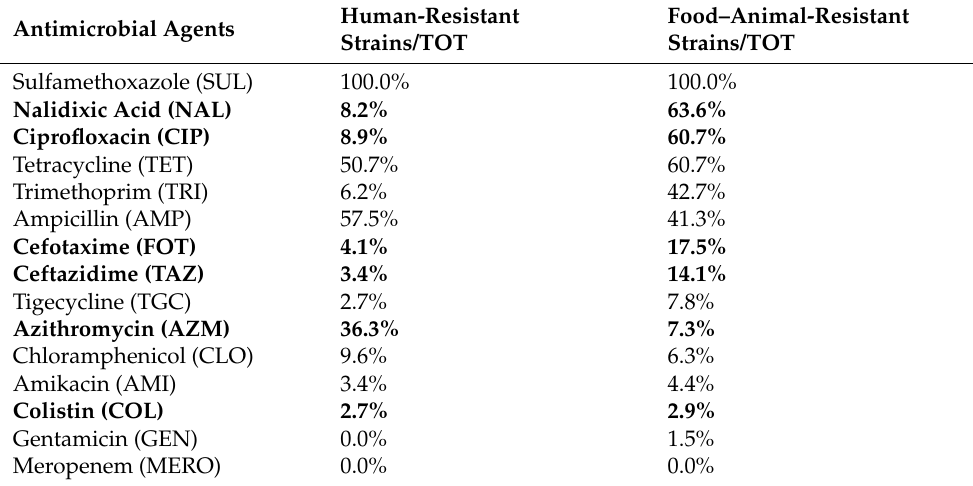
Table 1. Resistance percentage of the total strains to single antimicrobial agents. In bold are the highest priority critically important antimicrobials.